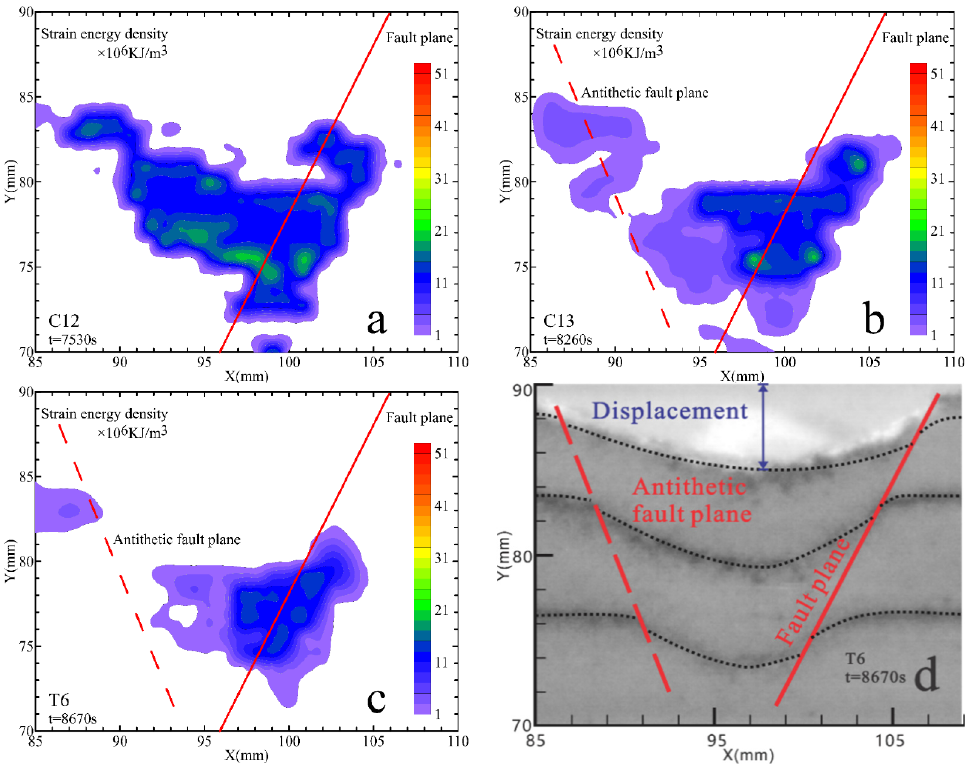
Figure 17. Strain energy density distribution at ( a ) C 12, t = 7530 s; ( b ) C 13, t = 8260 s; ( c ) T6, t = 8670 s; and, ( d ) the normal fault from the simulation chamber at T6, t = 8670 s. The inception stage of the antithetic going into the start of the elementary stage for the antithetic fault.